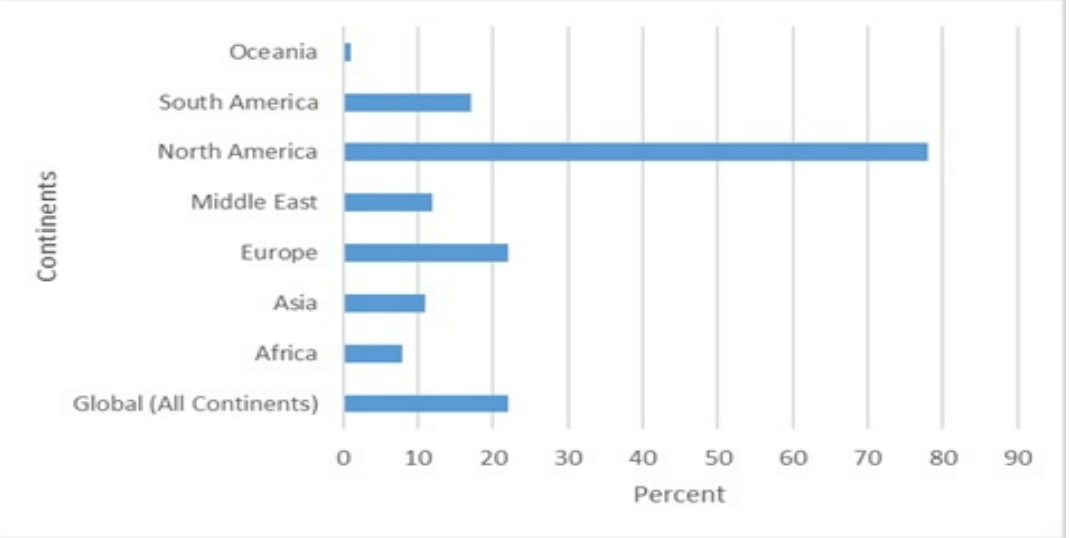
Figure 13. Demographics of Organisations’ sector.